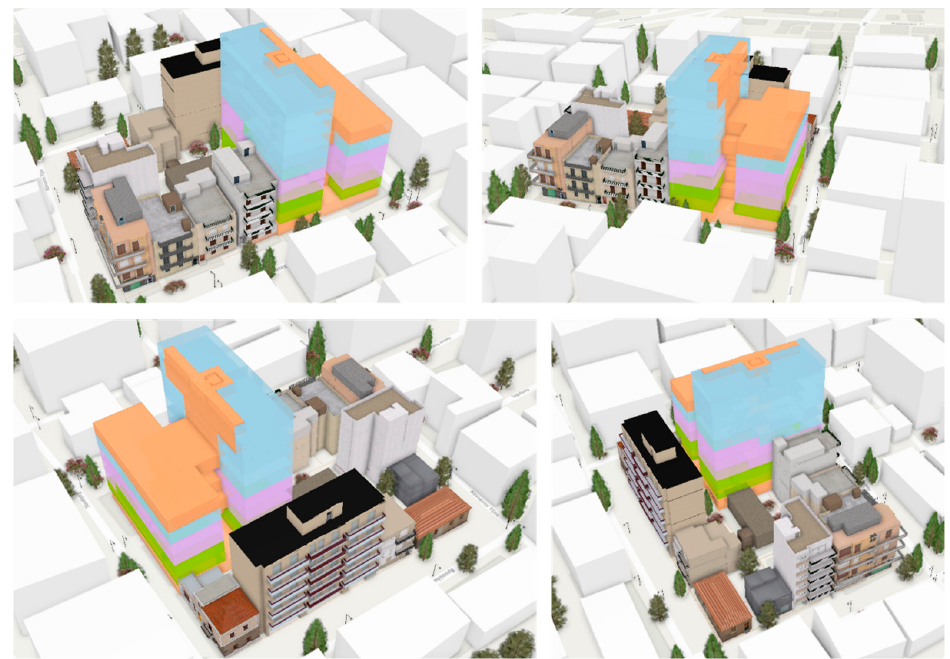
Figure 7. 3D views of the urban block of interest of the future scenario, where the new building is illustrated in LoD1 using different colors for each apartment/common area (purple: apartments for old owners; blue: apartments for the developer; green: apartments for affordable housing; orange: common areas).